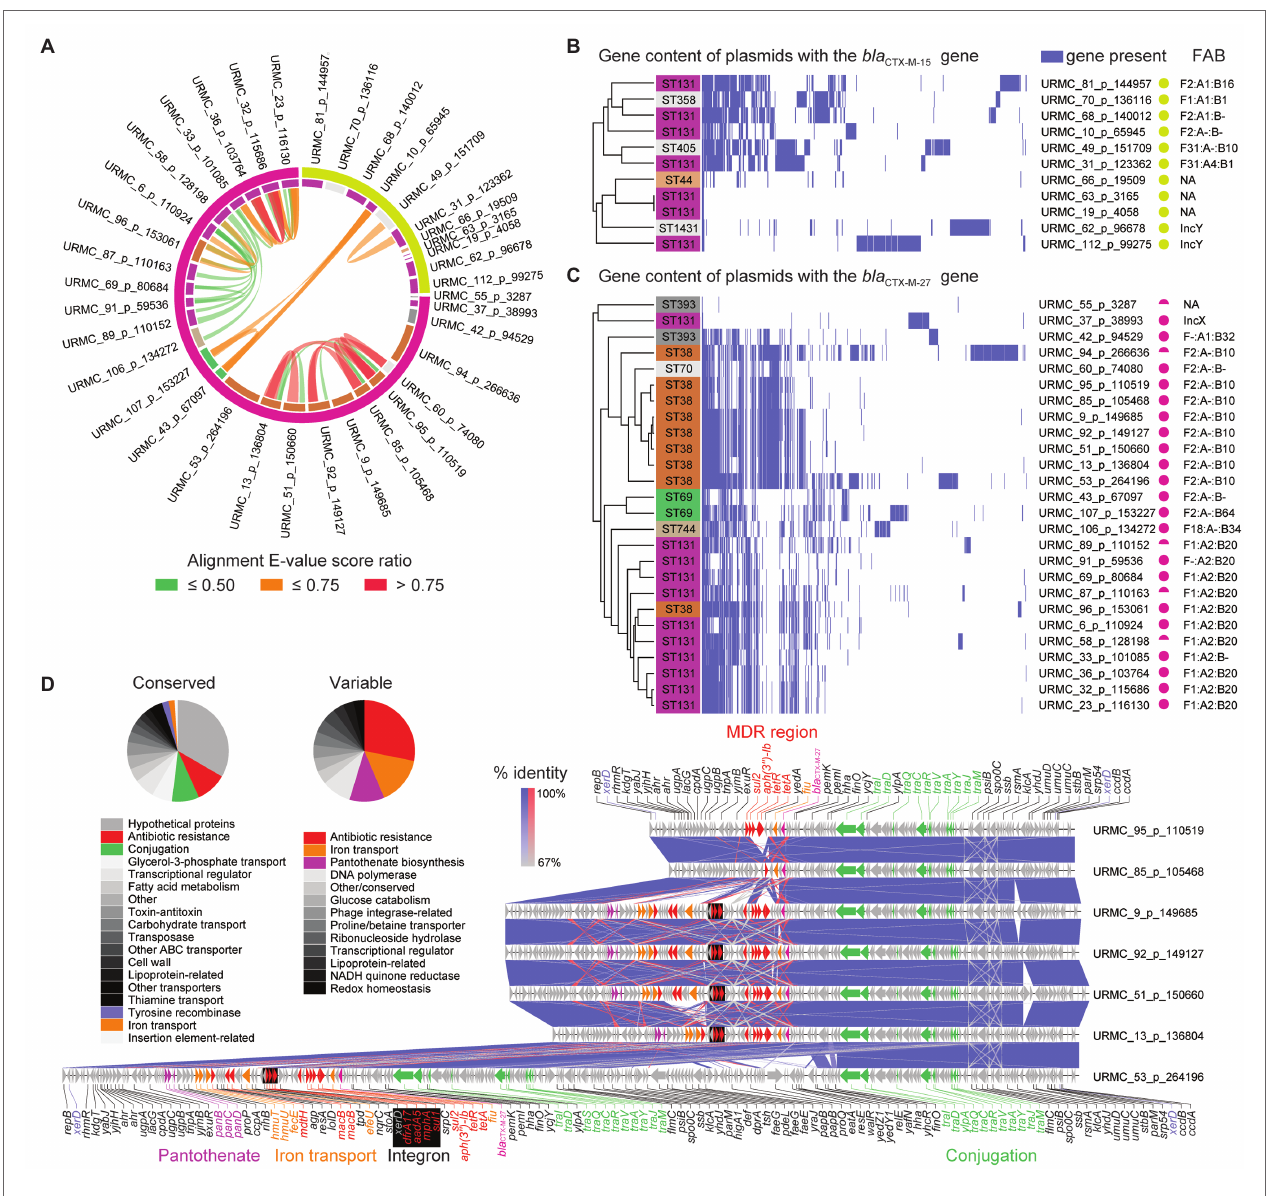
FIGURE 3 | Plasmids harboring the bla CTX-M-15 and bla CTX-M-27 β -lactamase genes. (A) Circular alignment plot of plasmids with either bla CTX-M-15 or bla CTX-M-27 genes showing E. coli ST (inner ring; color key consistent with Figure 2A ) and β -lactamase (outer ring). Ribbons colored by alignment E-value score ratio. (B) Gene content of all plasmids harboring the bla CTX-M-15 gene. Detected genes shown in blue with hierarchical clustering. (C) Gene content of all plasmids harboring the bla CTX-M-27 gene. Detected genes shown in blue with hierarchical clustering. (D) Gene schematic and linear alignment of complete plasmids encoding the bla CTX-M-27 gene from ST38 (with genes shown as arrows). Arrows are colored to show antibiotic resistance genes (red), conjugation-associated genes (purple), and other/ hypothetical genes (gray). Pie charts show relative frequencies of annotated genes by functional characteristics found in conserved (left) and variable (right) regions in plasmids with the bla CTX-M-27